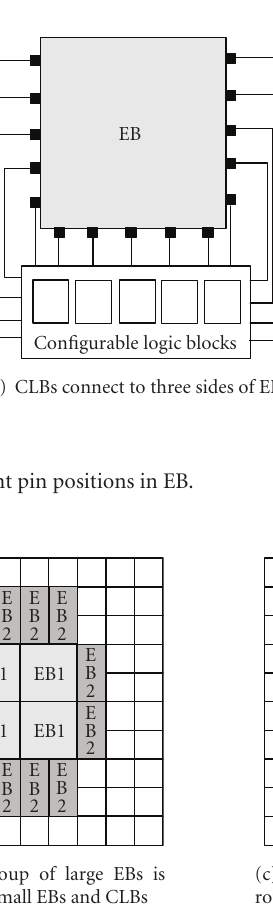
Figure 6: Various positions of the multiple EBs.